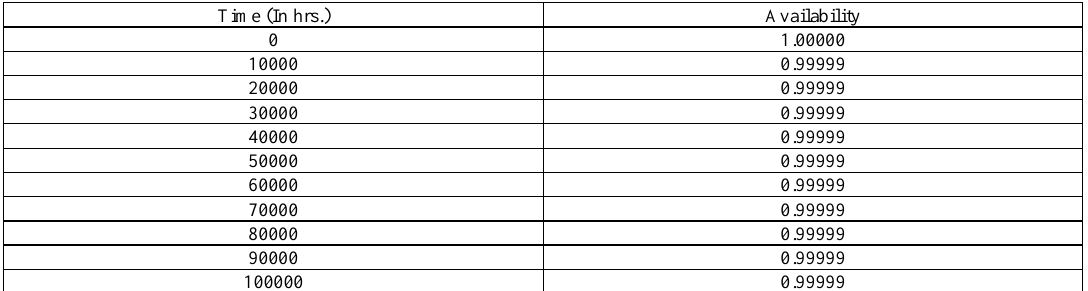
Table 3. Availability of the system.